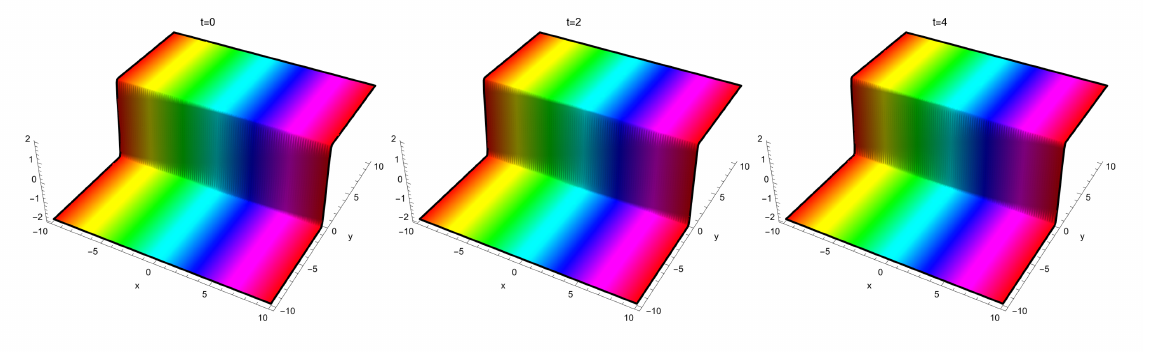
Fig. 1. The solution w 1 ( x , y , t ) for κ = 2, ω = 0.9, µ 1 = 0.5, µ 2 = 0.7, µ 3 = 0.9; α 0 = 0.3.